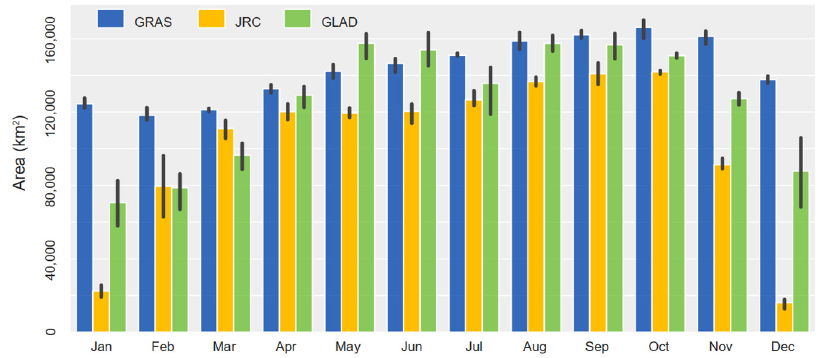
Figure 6. Monthly surface water area statistics for mainland China, as detected by GRAS-SWD, JRC-GSWE and GLAD-GSWD, respectively.